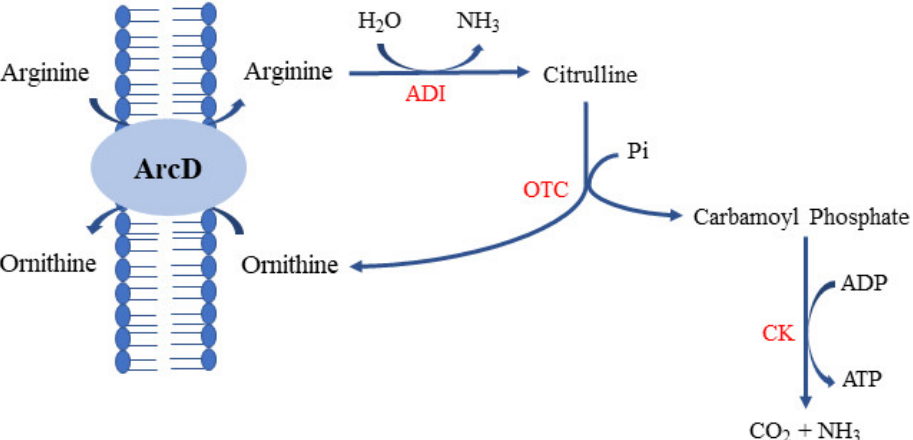
Figure 2. Schematic representation of the arginine deiminase (ADI) pathway. ADI, arginine deiminase encoded by arc A; OTC, ornithine transcarbamylase encoded by arc B; CK, carbamate kinase encoded by arc C; ArcD, arginine/ornithine antiporter encoded by arc D. Red pepper powder (RPP) is an important ingredient for kimchi, and RPP has been